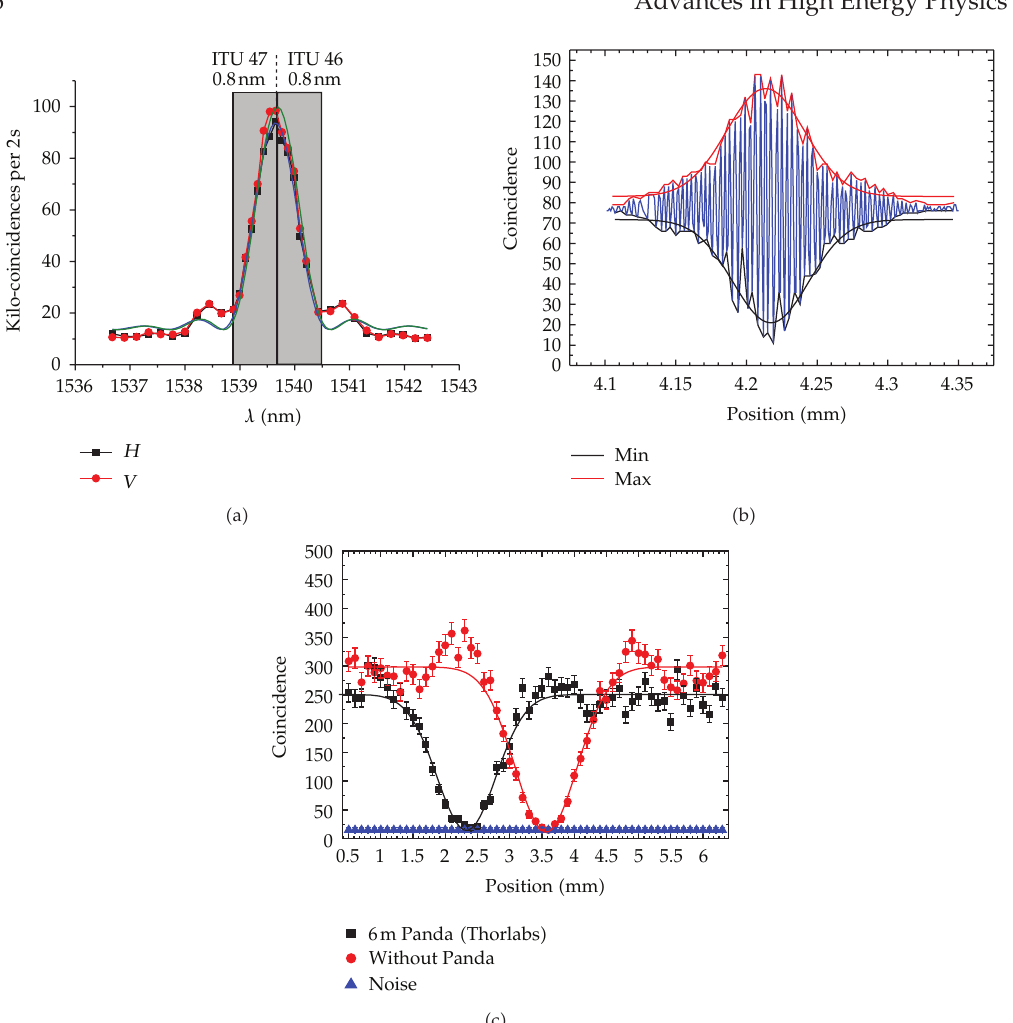
Figure 4: Temporal compensation of the photons: (cid:8) a (cid:9) spectrum of the two polarizations with the two filter ITU windows; (cid:8) b (cid:9) delay induced by the waveguide anisotropy; (cid:8) c (cid:9) delays compensated by 6 metres of polarization maintaining